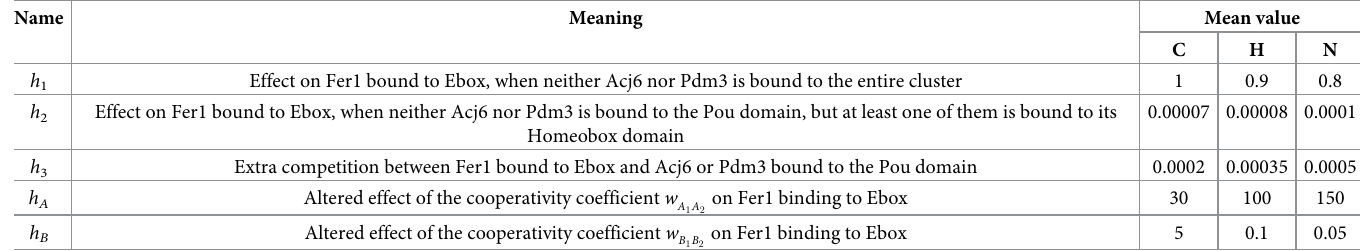
Table 4. Epigenetic parameters: Names, meanings and numerical values. Parameters describing the epigenetic factors included in the model. The values represent the mean of a normal distribution of standard deviation equal to mean/10, see Fig. D of S1 Text.